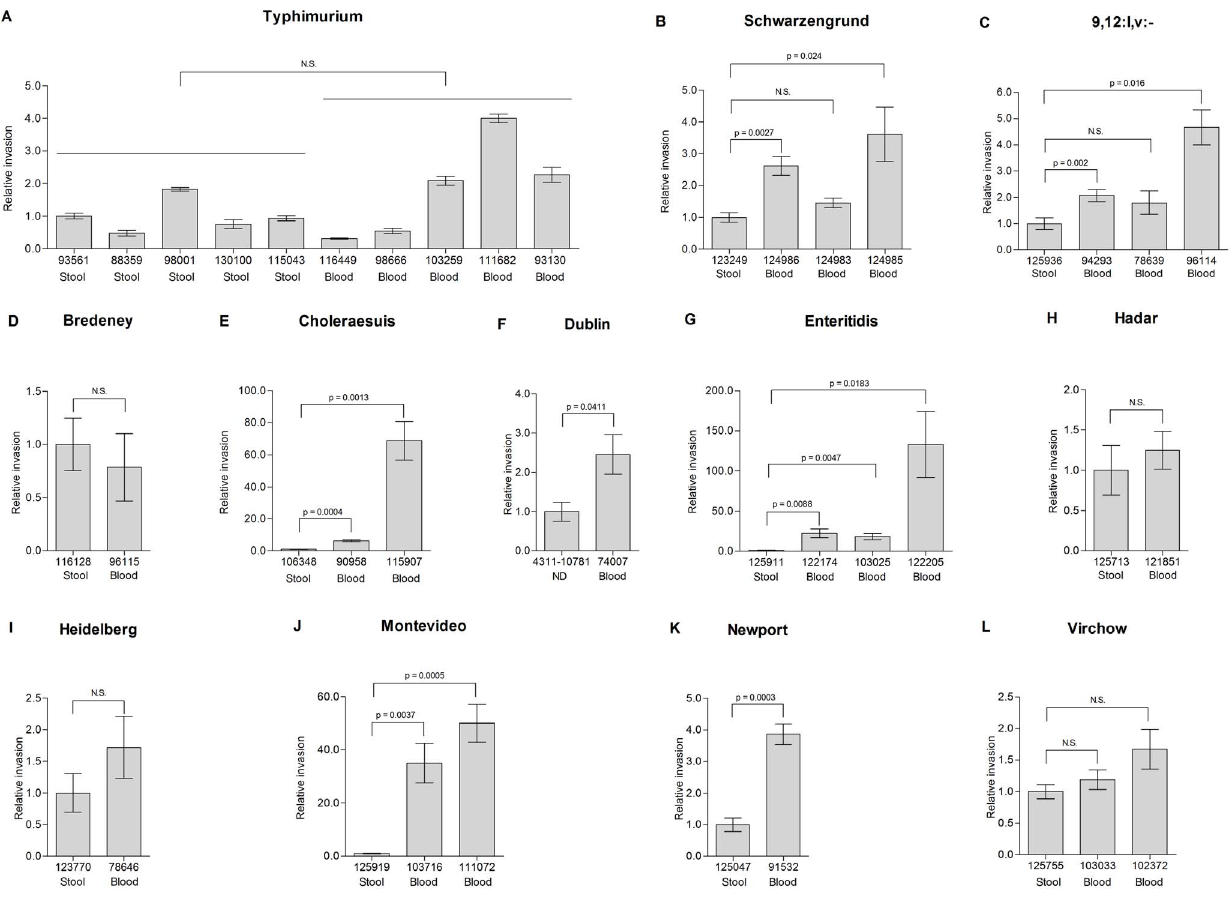
Figure 6. Invasion of bacteremic and enteritis strains into human epithelial cells. Clinical isolates from 12 NTS serovars from blood (invasive) and stool (gastrointestinal) sources were grown to late logarithmic phase in LB medium and used to infect HeLa cells at a MOI of , 100:1. The invasion of each strain (source and isolate number are indicated below each bar) is shown in relation to the invasion of the stool isolate in each serovar. In S . Typhimurium, invasion is presented relative to median value of the stool isolates (isolate 93561). Indicated values present the mean and the standard error of the mean (SEM; represented by the error bars) of at least 4 independent infections. ND, no data, as the source of isolate 4311– 10781 from serovar Dublin is not known.